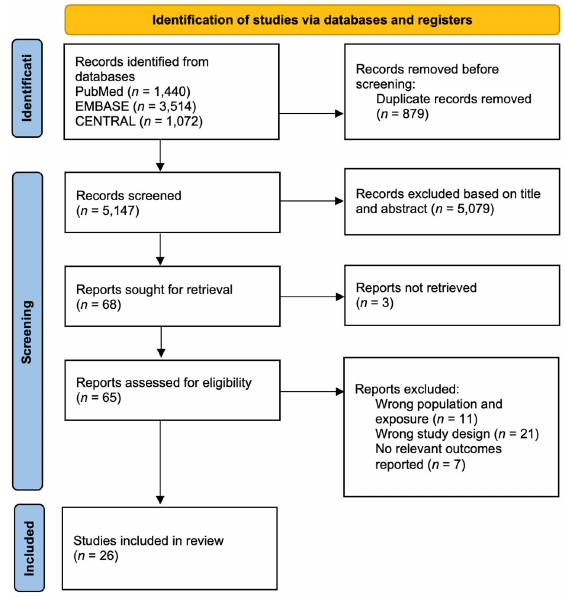
Figure 1. PRISMA flowchart.